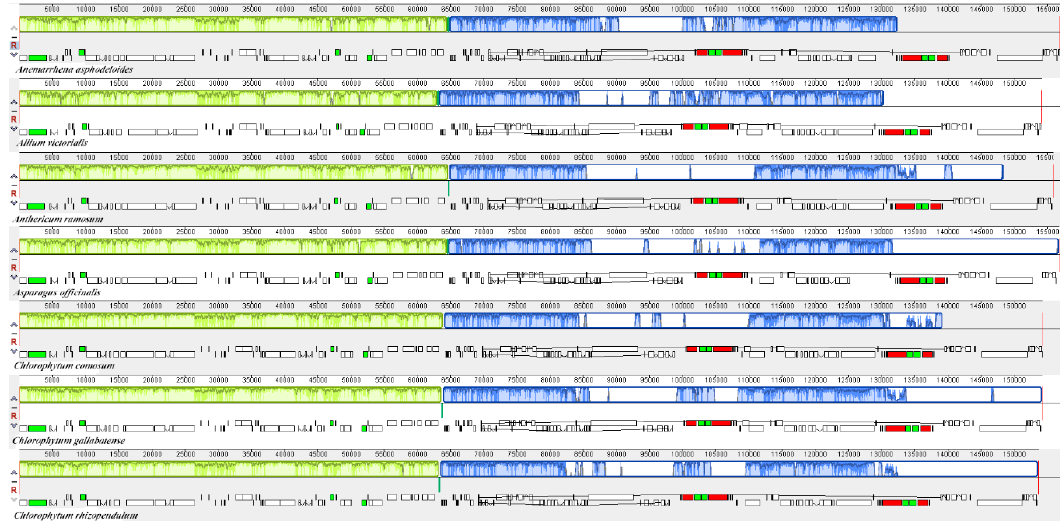
Figure 8. Comparison of the genome structure of seven Asparagales species using Mauve program. The DNA sequences above the line are presented in a clockwise direction, and those below the line in a counterclockwise direction.